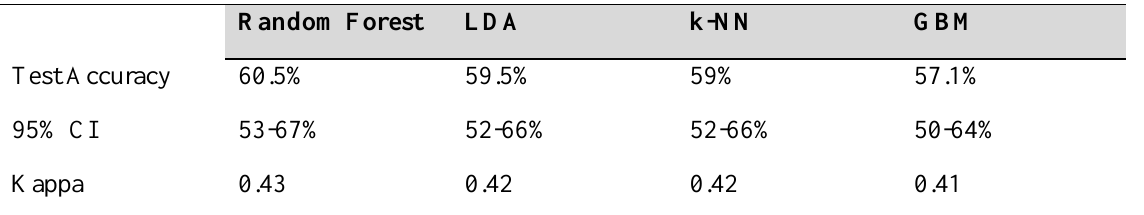
Table 2: Accuracy of each Algorithm on Test Set – Grade Prediction